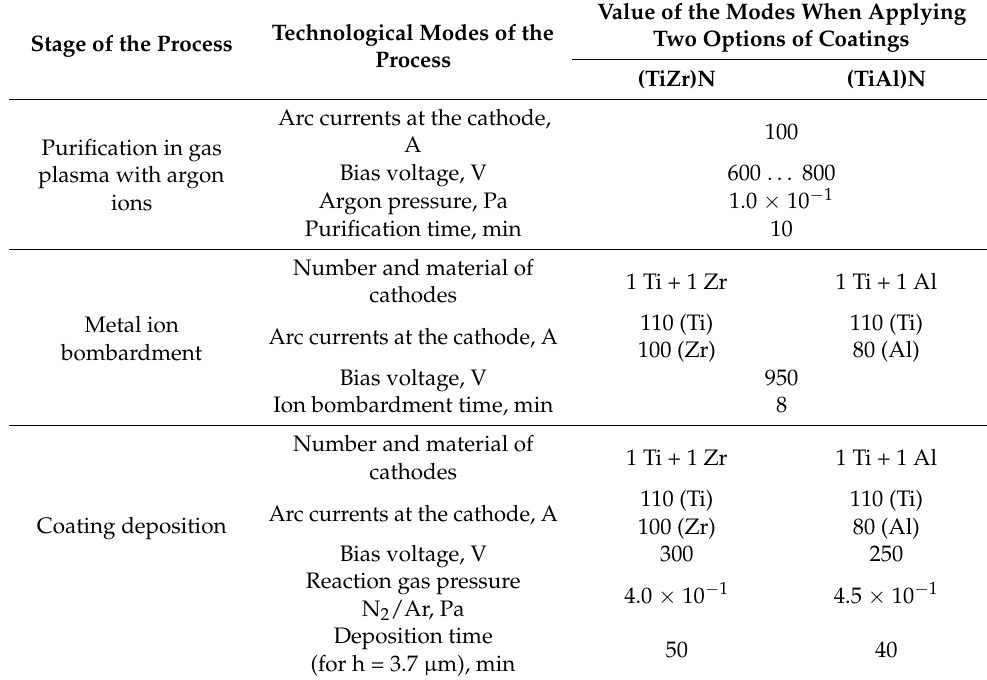
Table 2. Technological modes of coating on Al 2 O 3 +TiC ceramic inserts. Value of the Modes When Applying Technological Modes of the Stage of the Process Process Arc currents at the Purification in gas plasma with argon ions